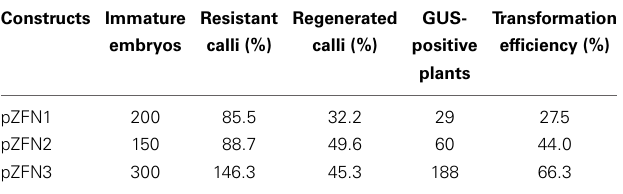
Table 1 | Transformation efficiency of embryogenic calli derived from immature embryos of IR64 rice infected with A. tumefaciens LBA4404 containing ZFN constructs.